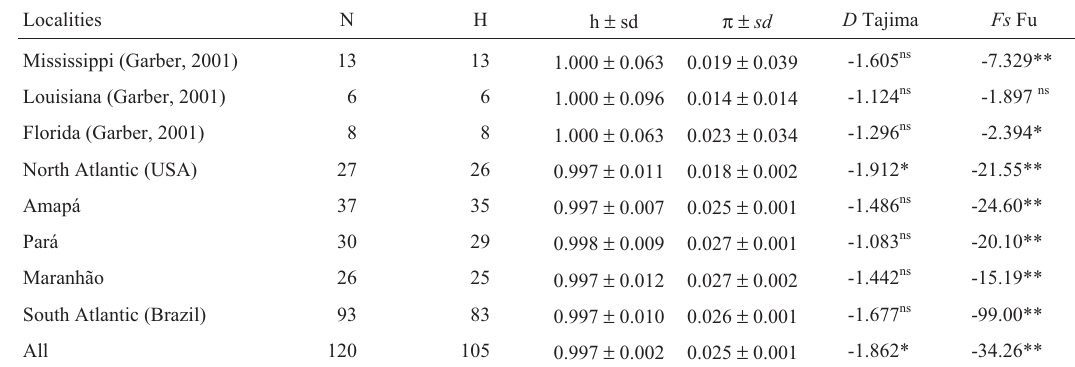
Table 1 - Measures of mitochondrial DNA haplotype ( h ) and nucleotide ( π ) diversity, and neutrality tests observed based on the D-loop region of red snappers from six localities of the Western Atlantic.